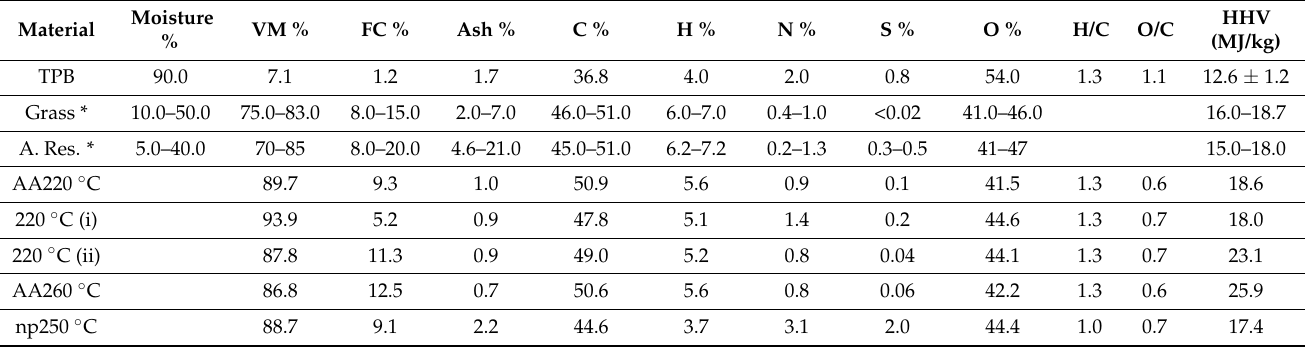
Table 3. Proximate and ultimate analyses of tomato plant biomass and HCs compared with other biomass